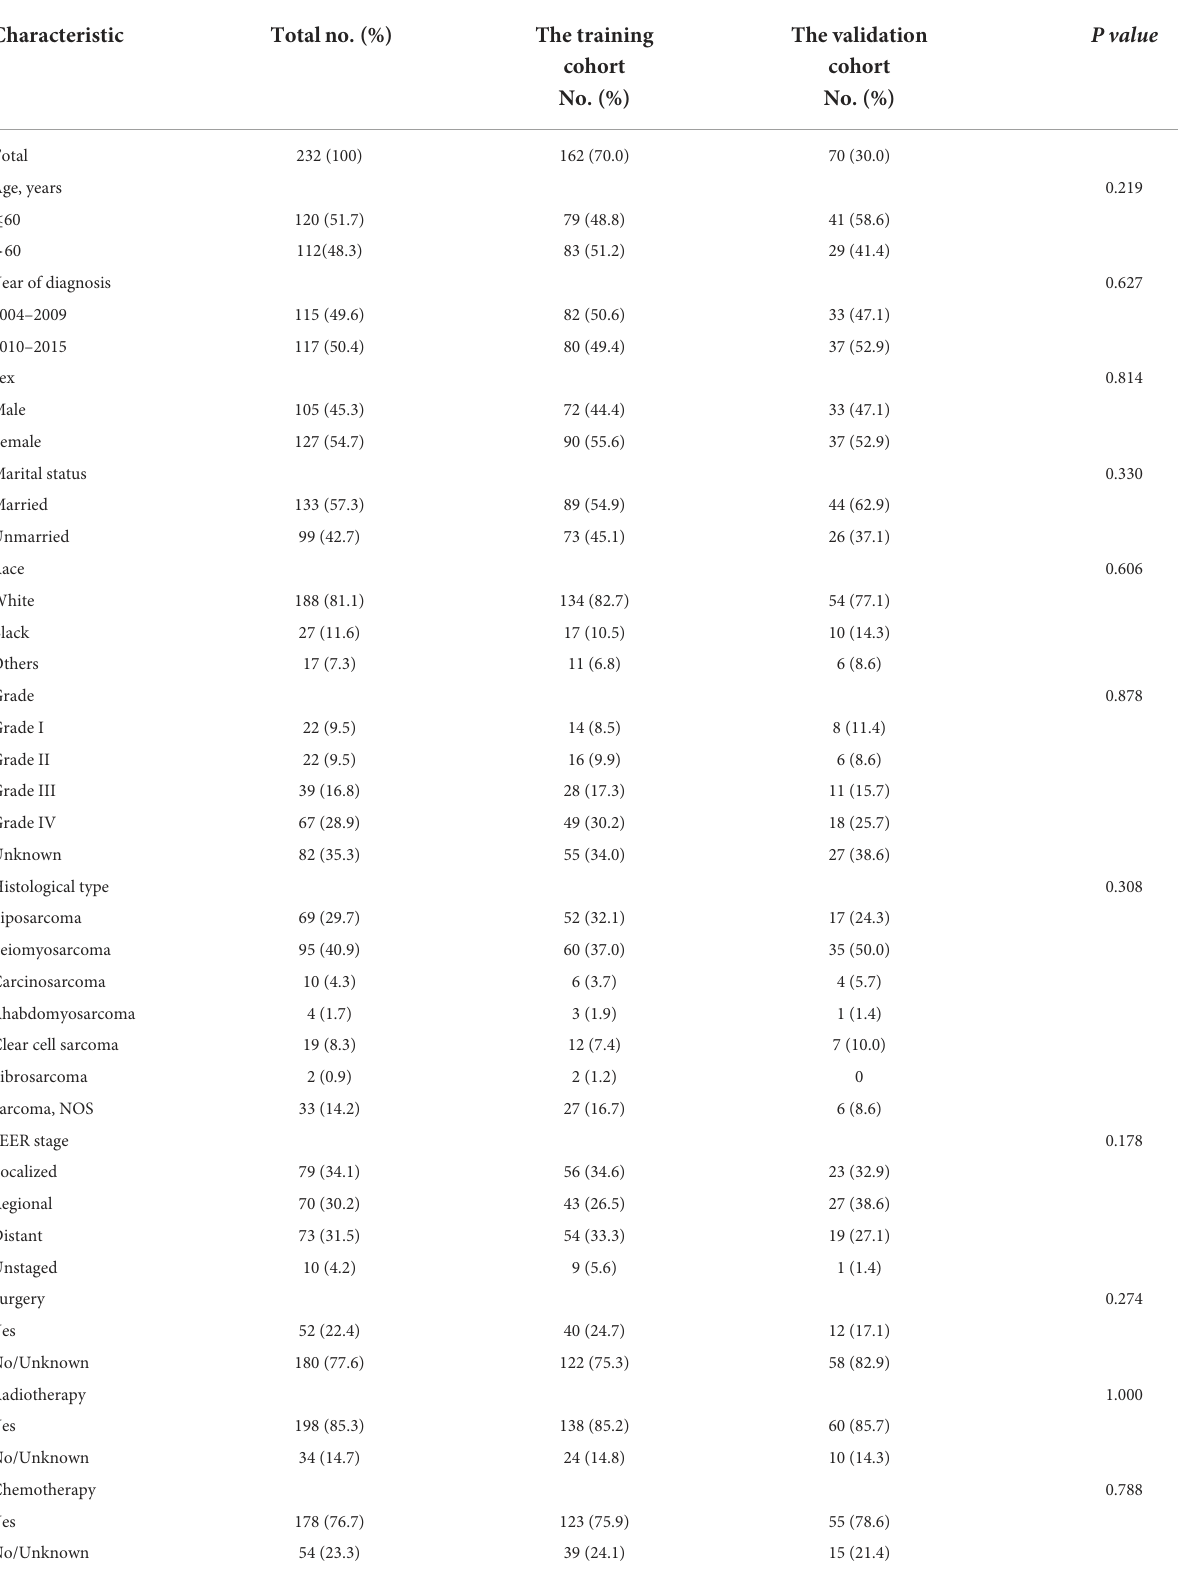
TABLE 1 Baseline demographic and clinical characteristics with adult renal sarcoma patients in our study. Characteristic Total no. (%) The training The